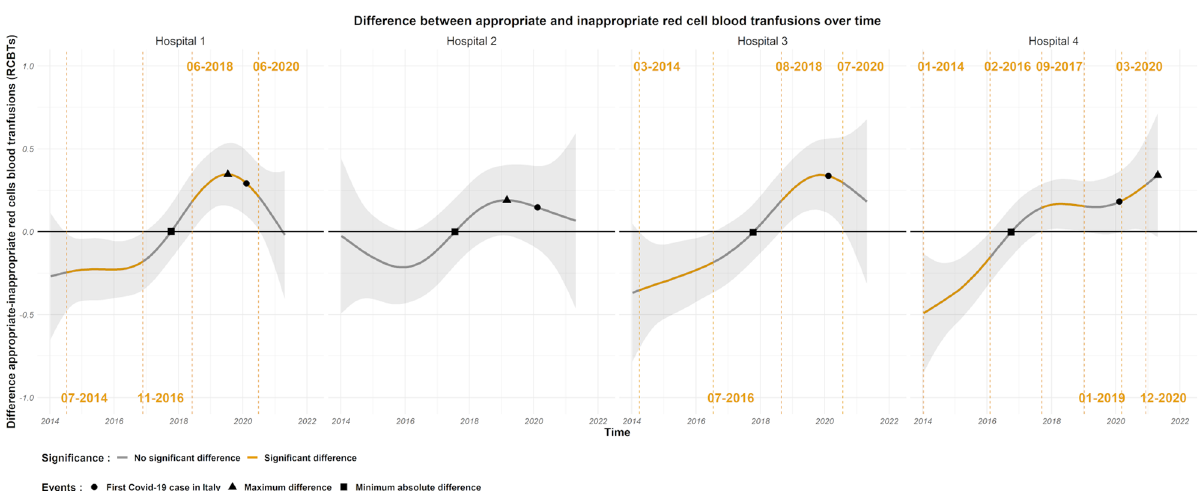
Figure 3. Average (across wards) difference in the smooth time trend between appropriate and inappropriate RBCTs at hospital sites 1 to 4. Time periods of significant difference (zero not included in the 95% CI) between the two smooth components are highlighted in yellow. The timepoint of the maximum difference between the two smooth components is visualized by a triangle, the time of zero difference by a square, and the first reported COVID-19 case in the region is represented by a